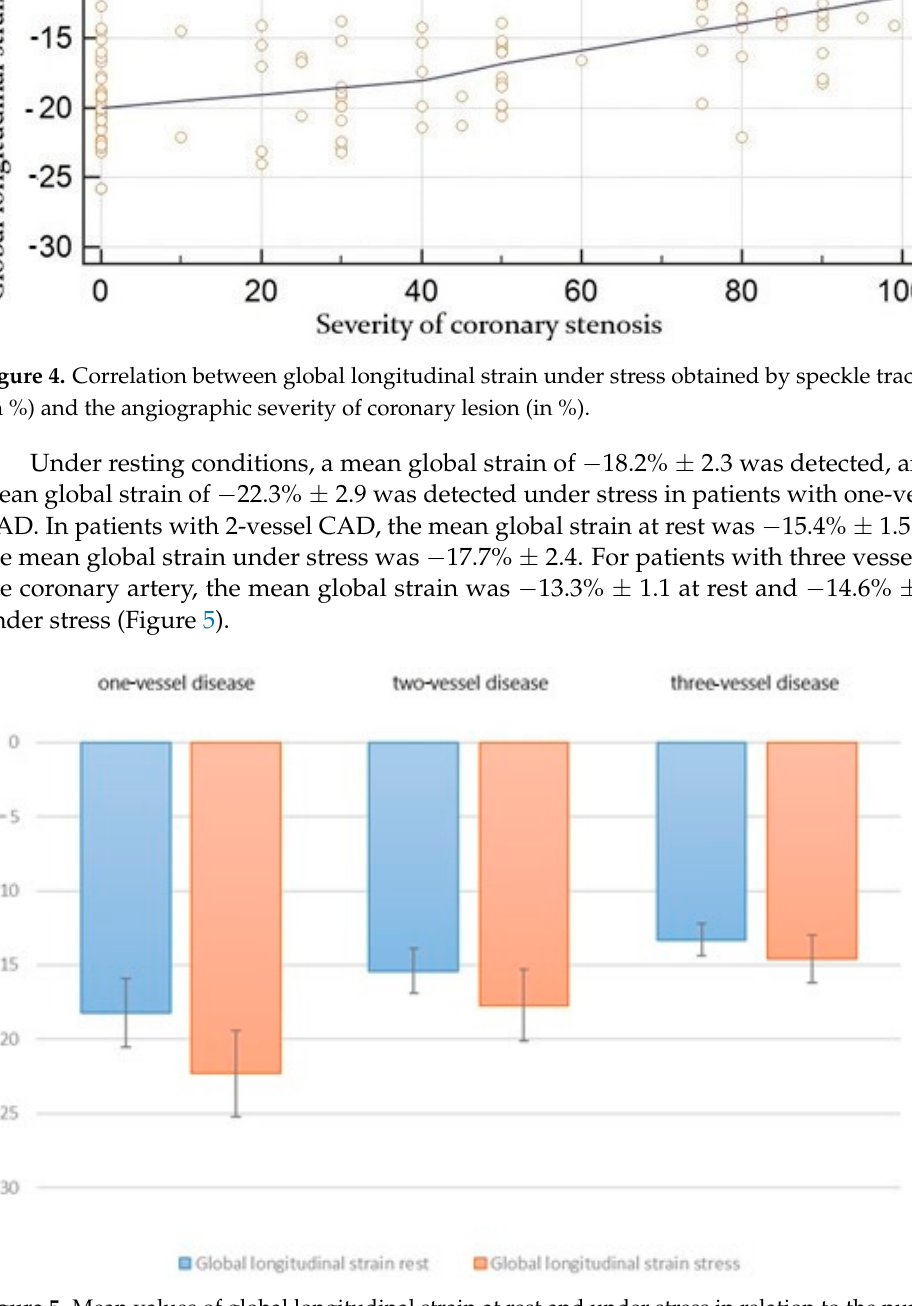
Figure 5. Mean values of global longitudinal strain at rest and under stress in relation to the number of involved coronary vessels.